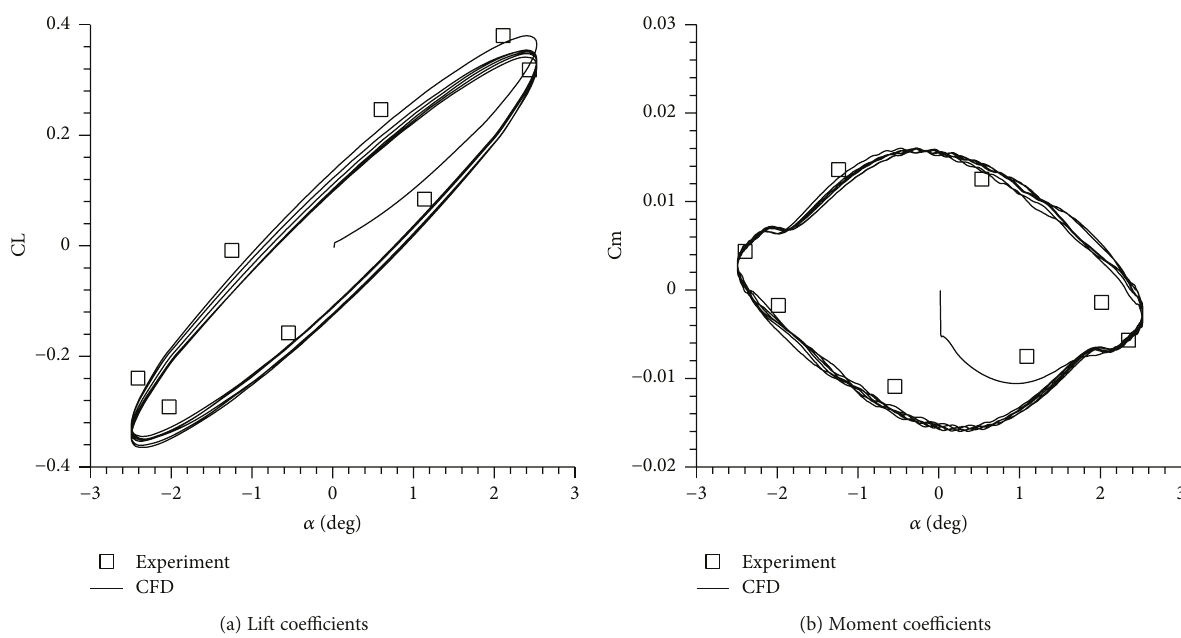
Figure 1: Comparison of aerodynamic coe ffi cients between CFD codes and